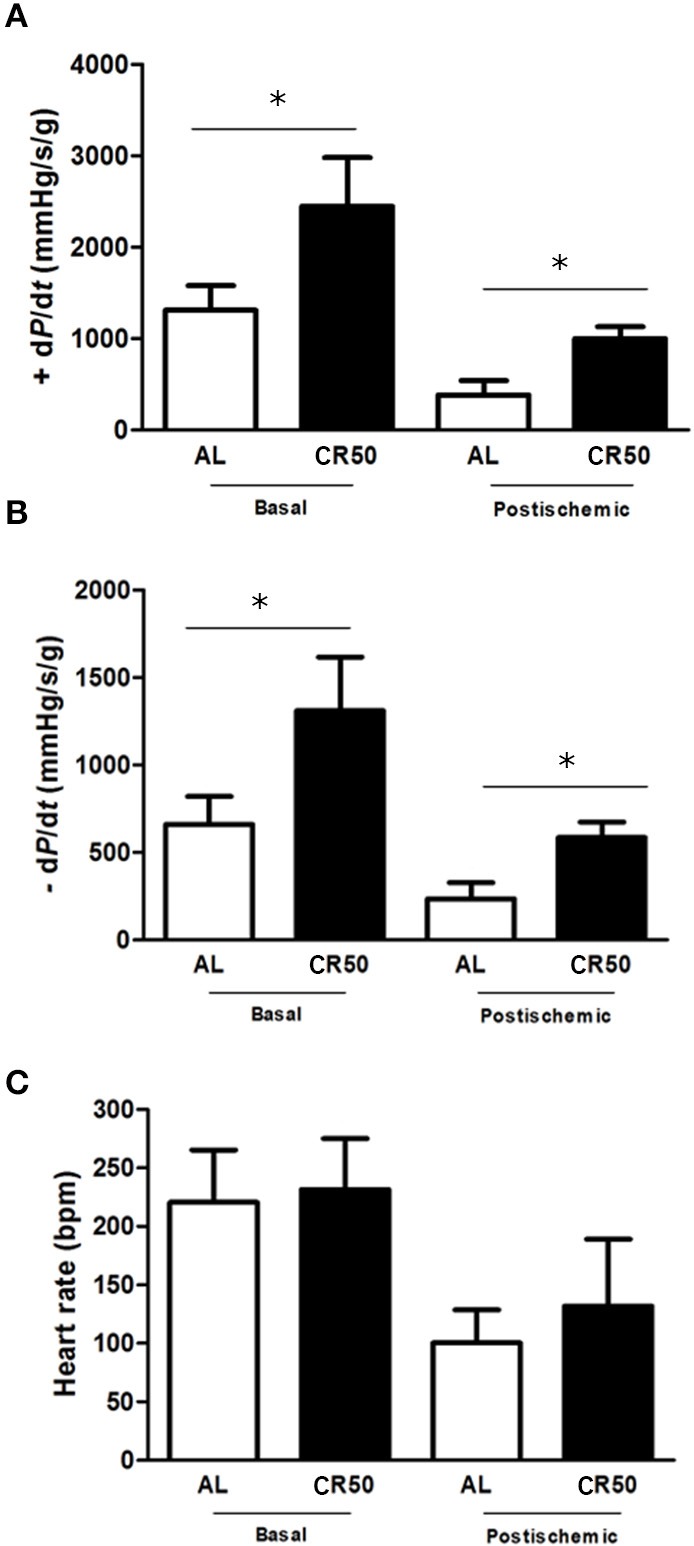
Severe calorie restriction improves basal and post-ischemic cardiac function. Ad Libitum (AL) and 50% Calorie Restricted (CR50) rats. Contractility index (+dP/dt) (A), relaxation index (−dP/dt) (B) and heart rate (C) of Ad Libitum (AL) and 50% Calorie Restricted (CR50) rats. Data are presented as mean ± SD. *P < 0.05. Anova one-way followed by Tukey post-hoc test.